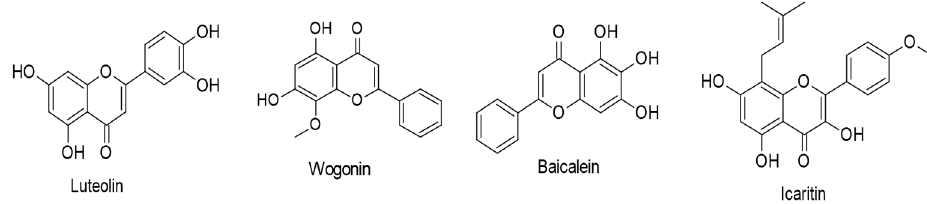
Figure 3. Chemical structures of flavones and prenylated flavonols with therapeutic actions against EBV-associated cancers.